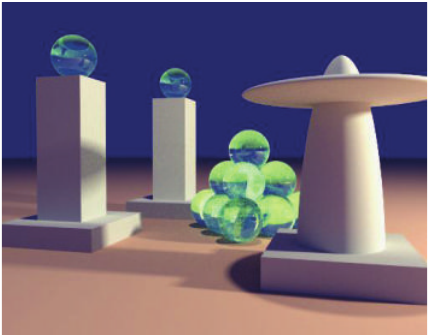
Figure 5: Scene from Kayija’s paper, rendered using our CUDA path tracing